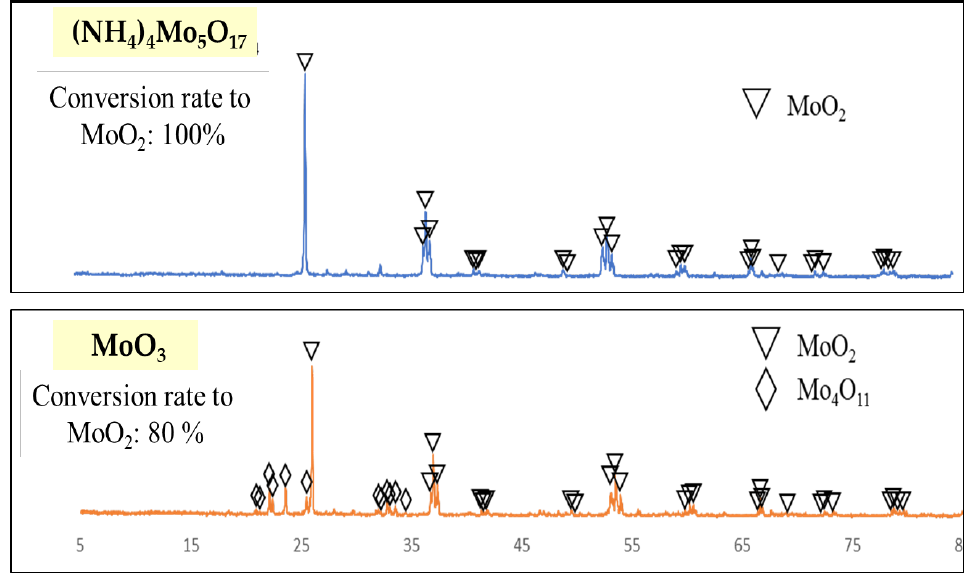
Figure 9. XRD patterns and conversion rates obtained after the first stage of hydrogen reduction at 575 °C for (NH 4 ) 4 Mo 5 O 17 and MoO 3 .